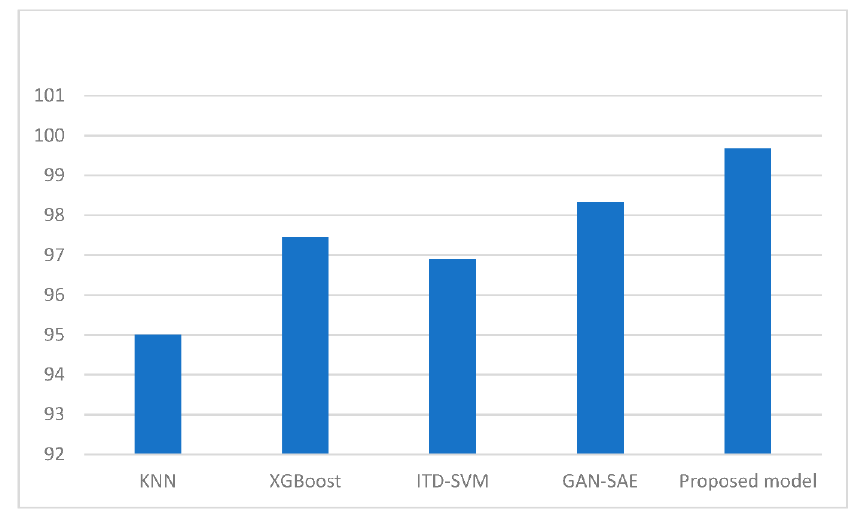
Figure 10. Comparison of Accuracy of some state-of-the-art techniques.